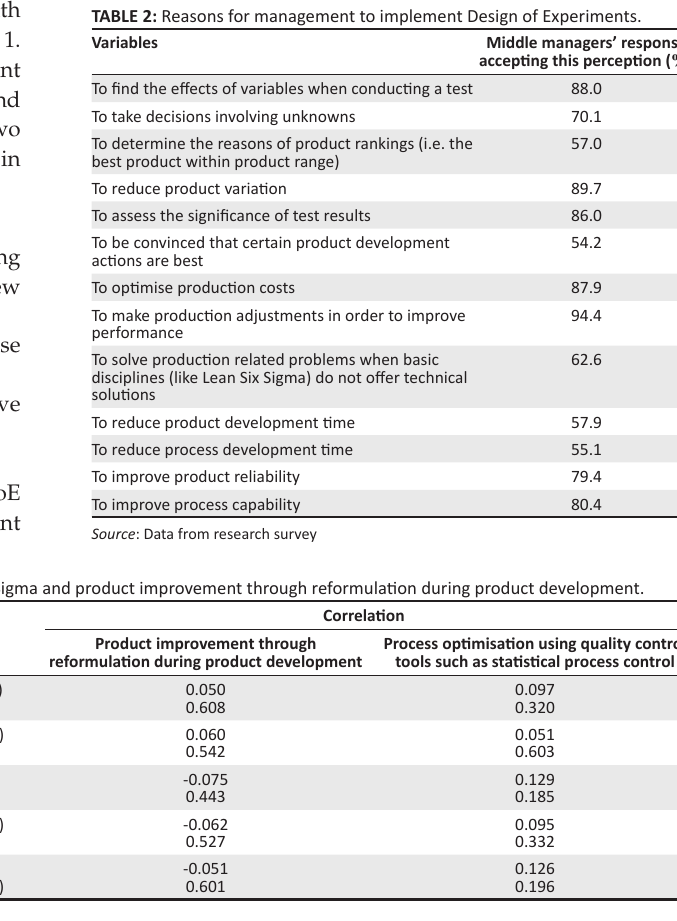
Table 2 provided high percentage response rates from middle